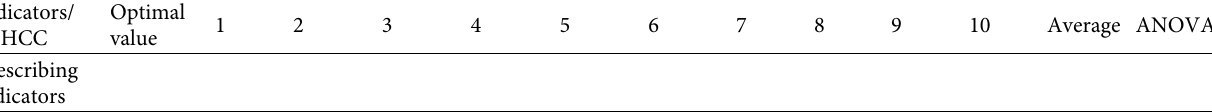
Table 1: WHO/INRUD drug use indicators at public primary healthcare centers in Kisii County,